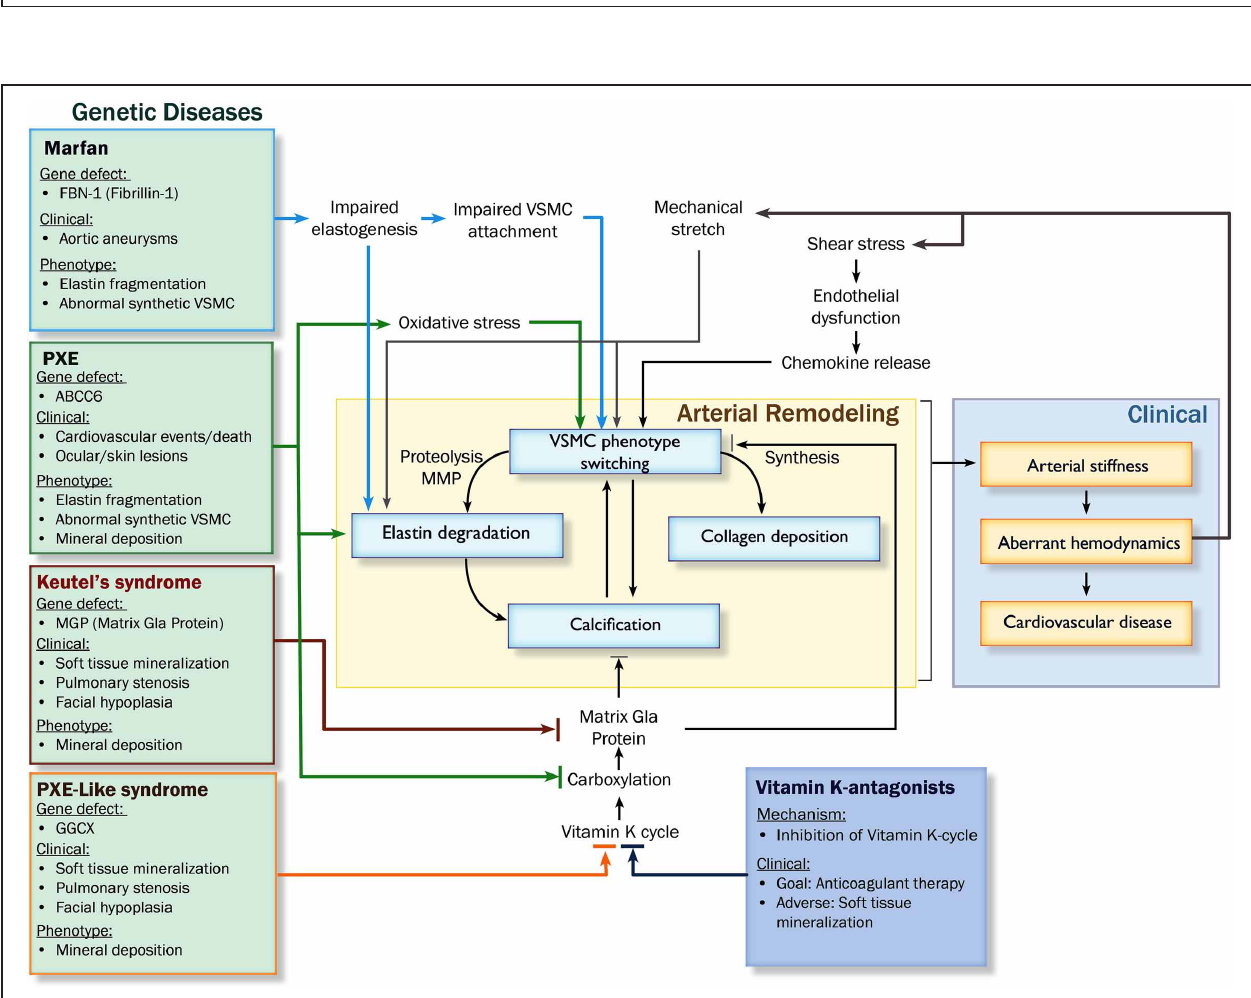
FIGURE 2 | Pathophysiological mechanisms of arterial remodeling. Cross sectional schematic view of the arterial wall. (A) Normal situation. (B) Arterial remodeling. Arterial remodeling is characterized by thickening of the wall. Elastic fiber degradation, extracellular matrix